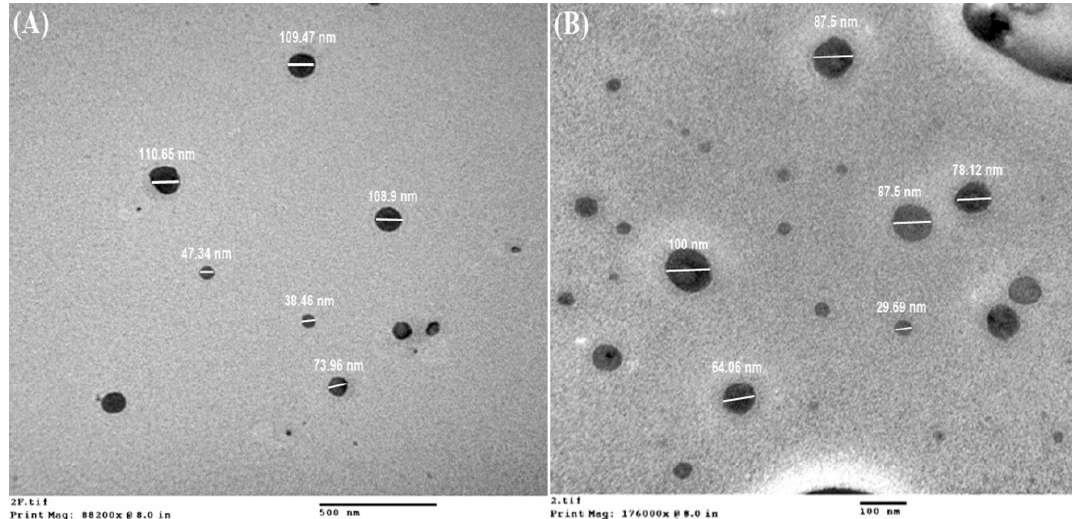
Figure 5. Particle size analysis of CPN. 216